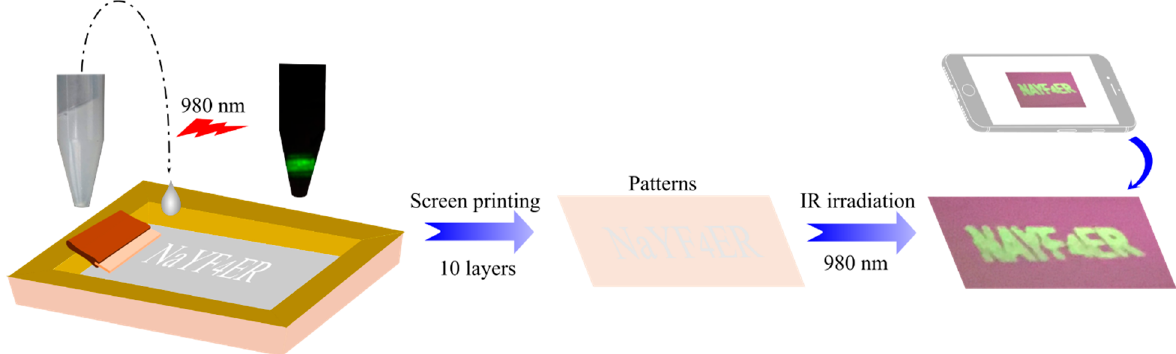
Figure 6. The procedure of screen printing. Table 1. Viscosity and surface tension of ink solutions with different weights of PVA .